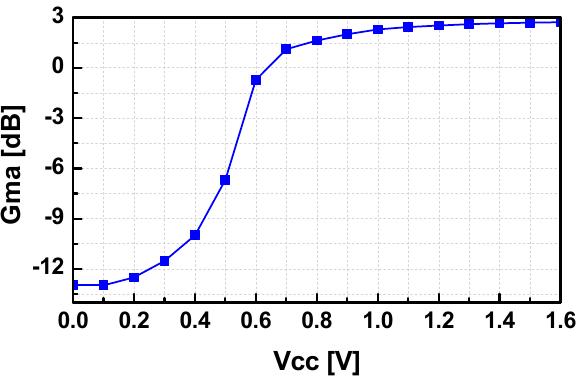
Figure 3. Simulated G ma at 280 GHz of the transistor (2 × 70 nm × 900 nm) versus supply voltage when the base bias current is fixed to 21 μ A.